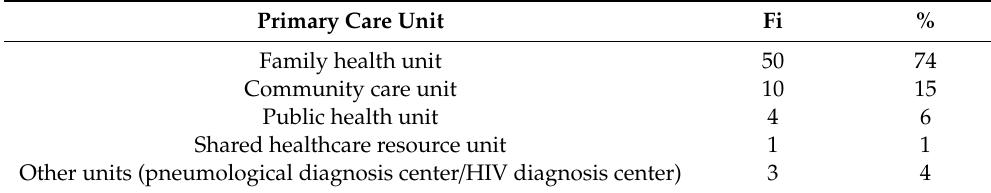
Table 3. Focus group participants profile concerning care unit where they